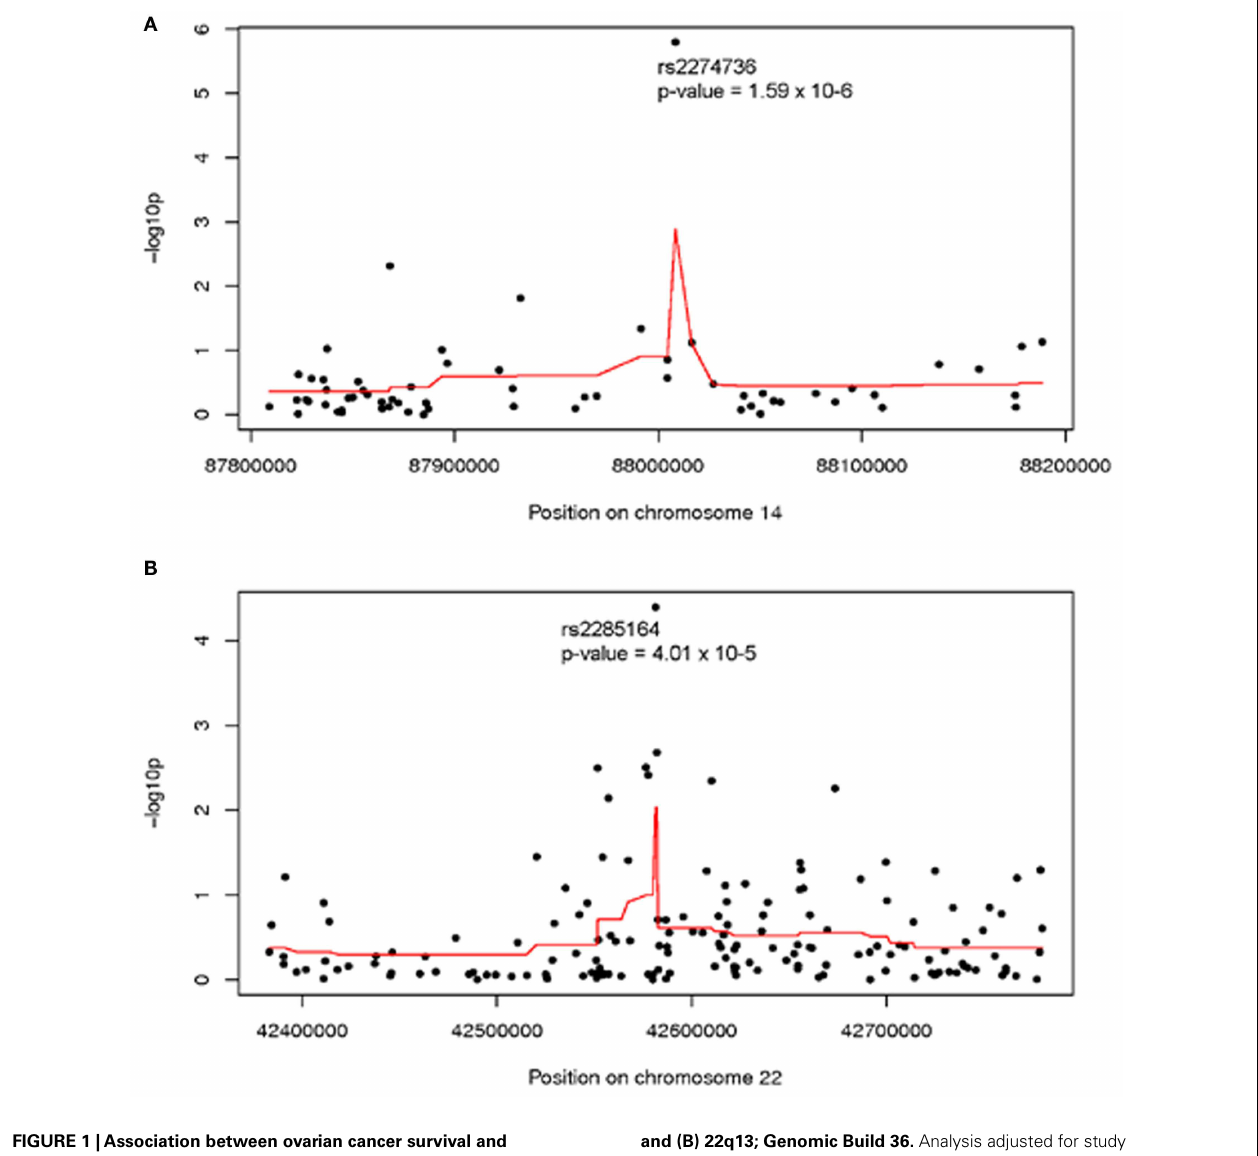
and (B) 22q13; Genomic Build 36. Analysis adjusted for study site, age at diagnosis, and first two population structure principal